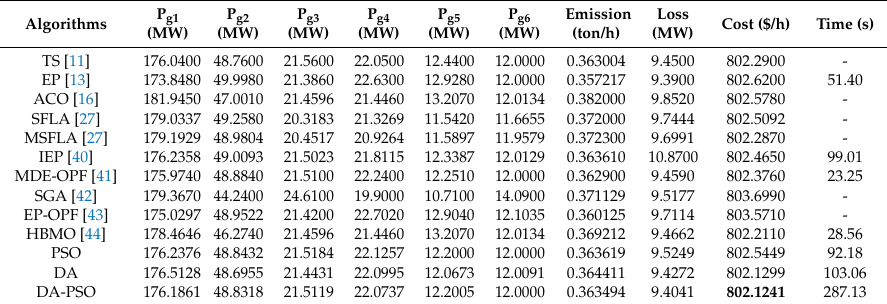
Table 2. Comparison of the results from DA-PSO and other algorithms when considering only fuel cost as part of the objective function for IEEE 30-bus system. Algorithms